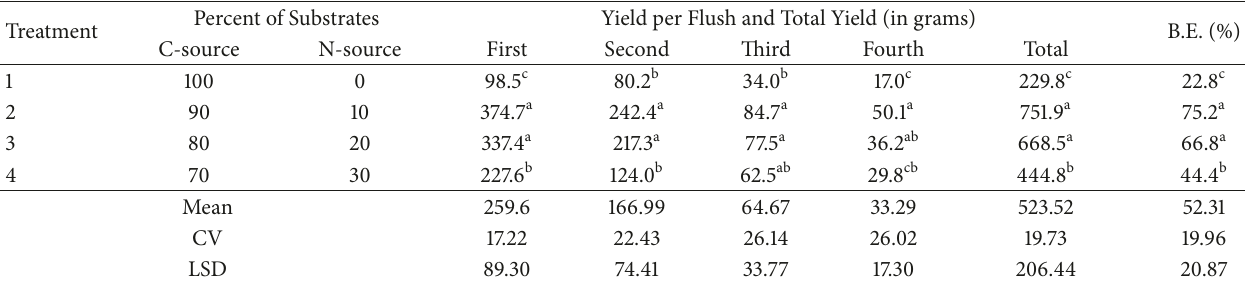
Table 2: Yield and B.E. of grey oyster ( P. sajor-caju ) mushroom.